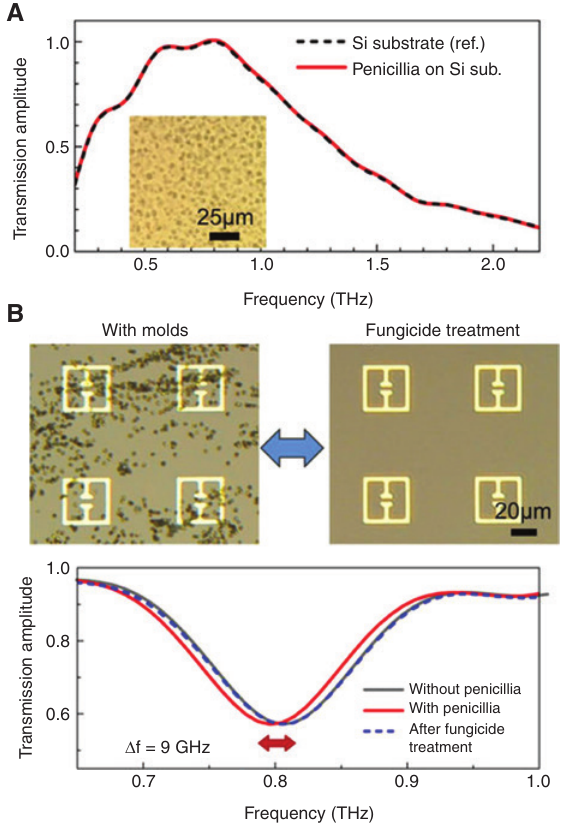
Figure 27: Detection of complex biological system by using THz metamaterial. (A) THz transmission amplitudes for bare substrate with (red solid line) and without (black dashed line) deposition of penicillia. (B) Microscope images of metamaterials with the deposition of penicil- lia a (left) and after fungicide treatments (right). (C) THz transmis- sion amplitudes measured before and after the fungicide treatment. This figure is reproduced from Ref.